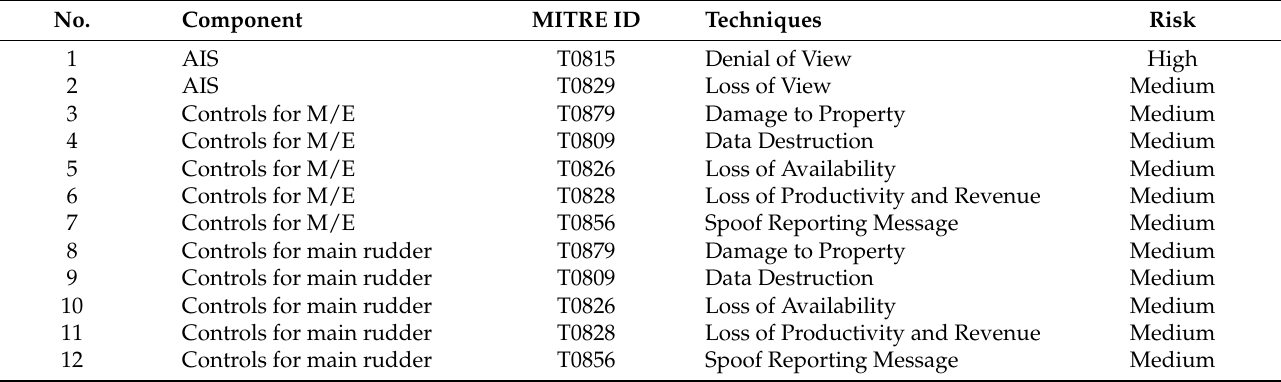
Table A1. Medium, high, and critical risks of an